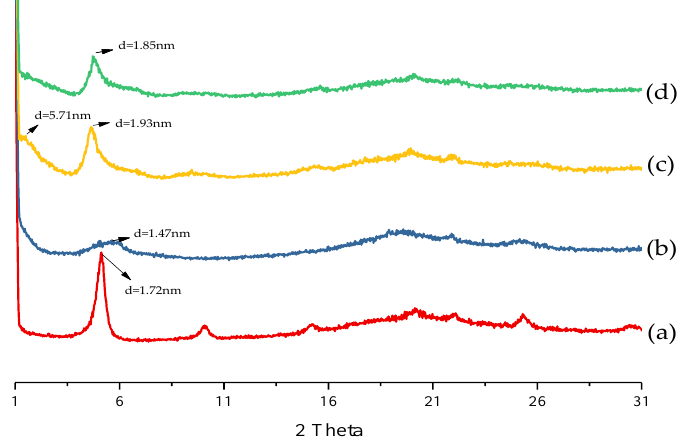
Figure 2. XRD patterns of (a) HPDSP-Na; (b) HPDSP-1231; (c) HPDSP-1631; and (d) HPDSP-1831.